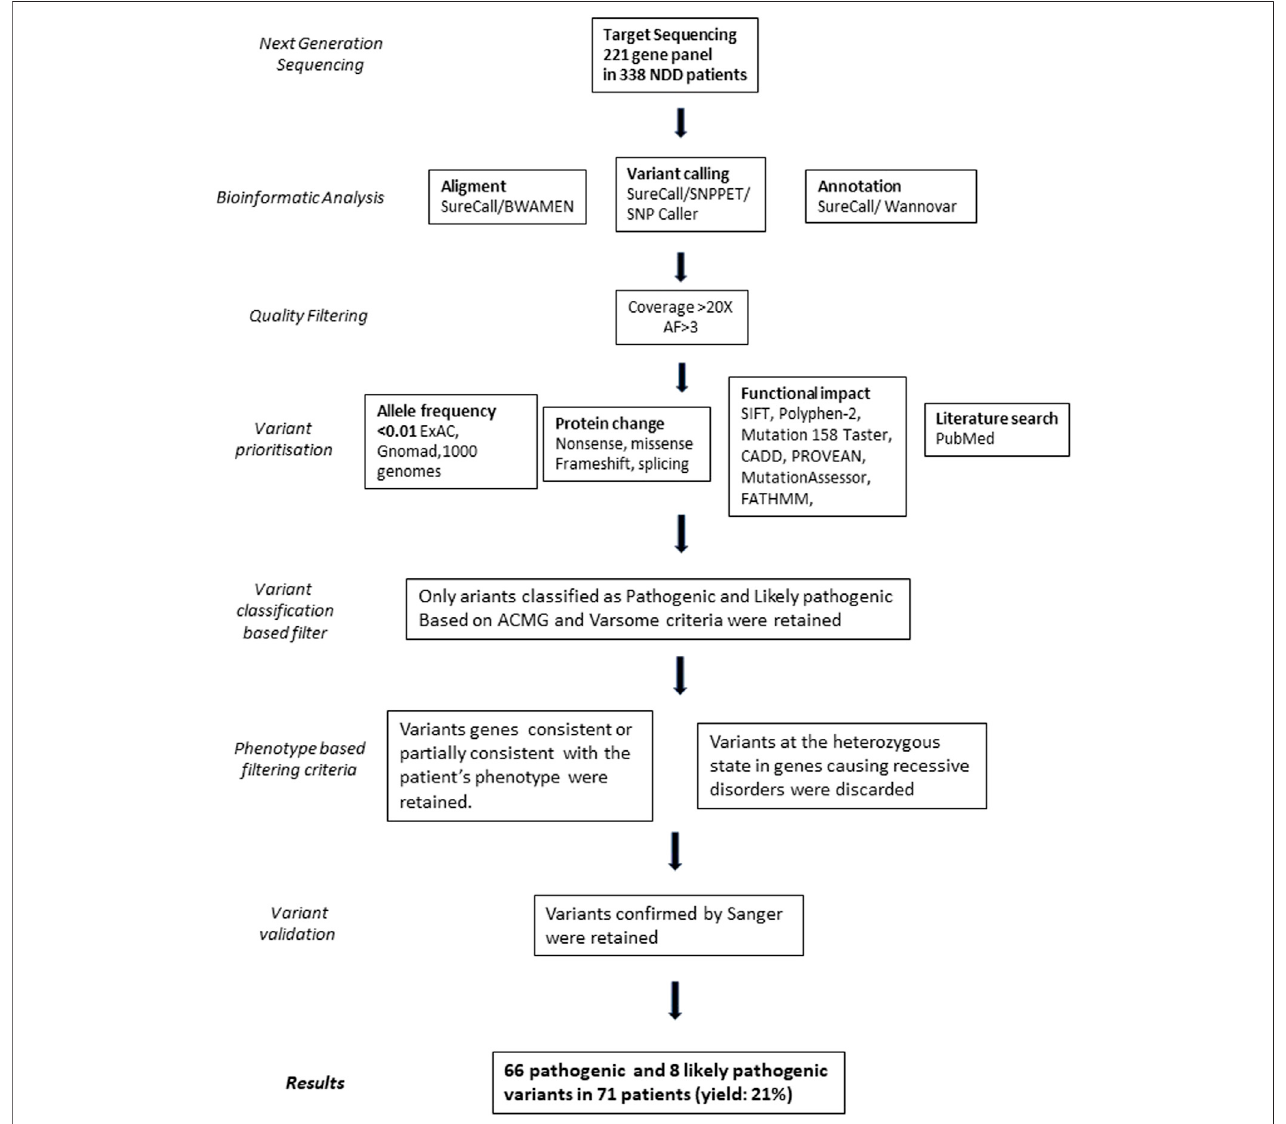
FIGURE 1 | Work fl ow describing the main step in the identi fi cation of the selected variants. AF, Allele frequency of the variant base relative to the read number.